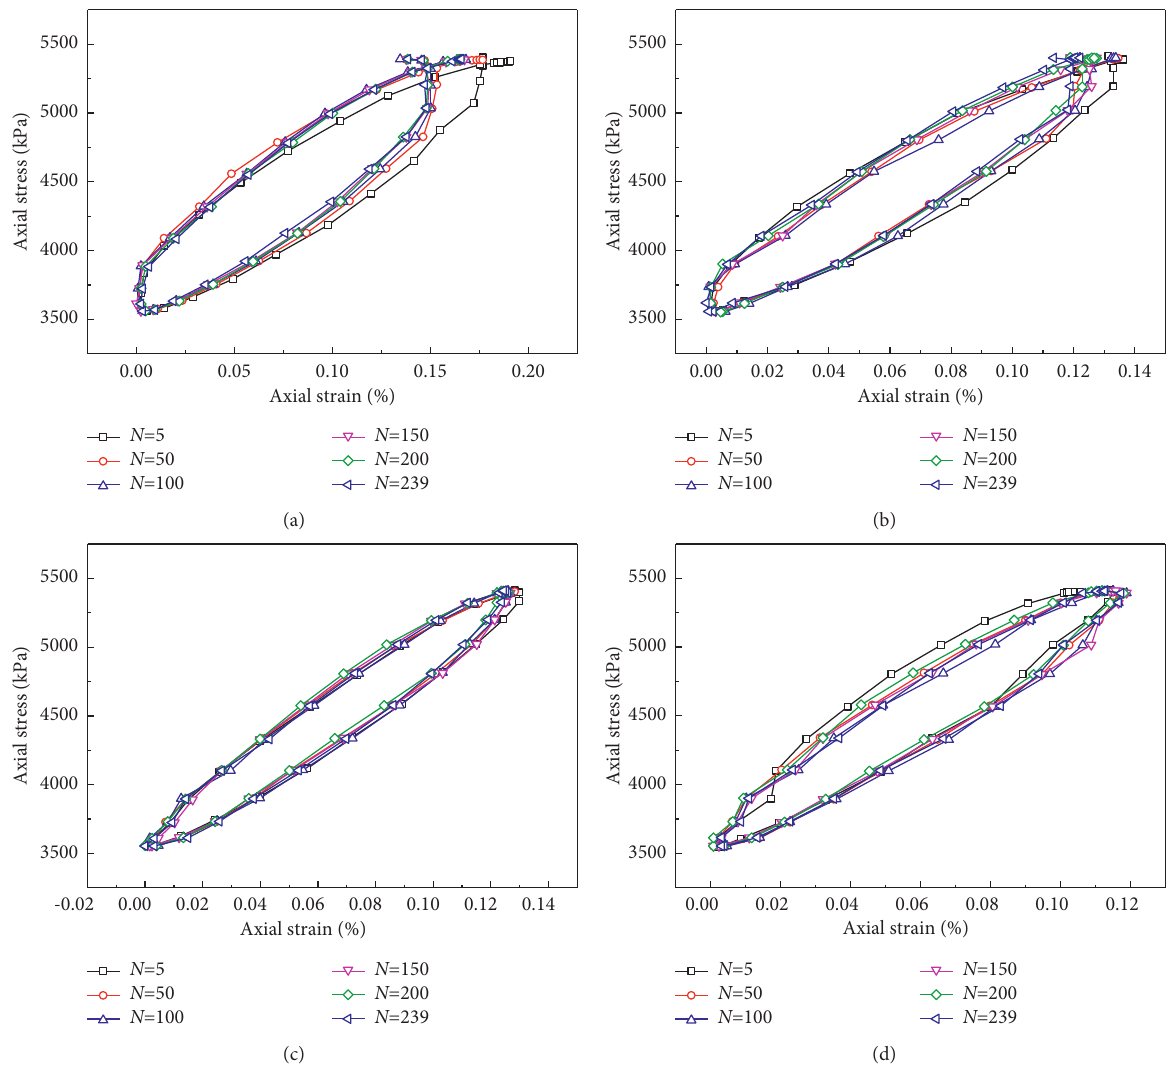
Figure 9: The evolution of representative axial stress-strain hysteresis loop versus the number of cycles at four temperatures as CSR � 0.375. (a) T � − 8 ° C. (b) T � − 10 ° C. (c) T �− 13 ° C. (d) T � − 15 ° C.